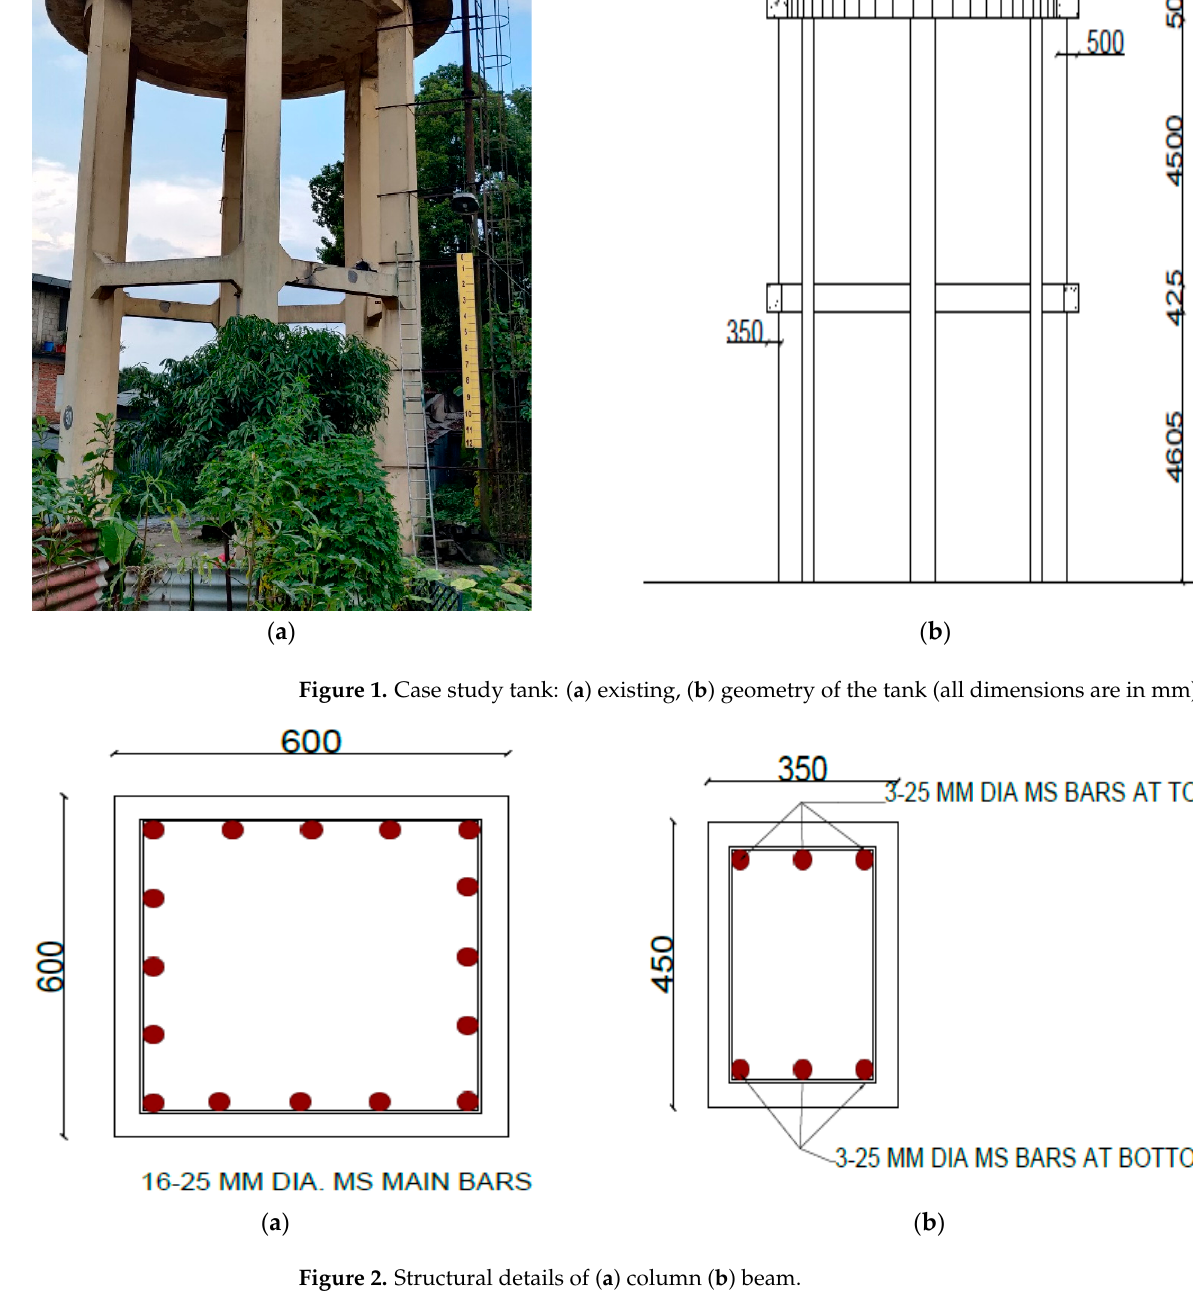
Figure 2. Structural details of ( a ) column ( b ) beam.